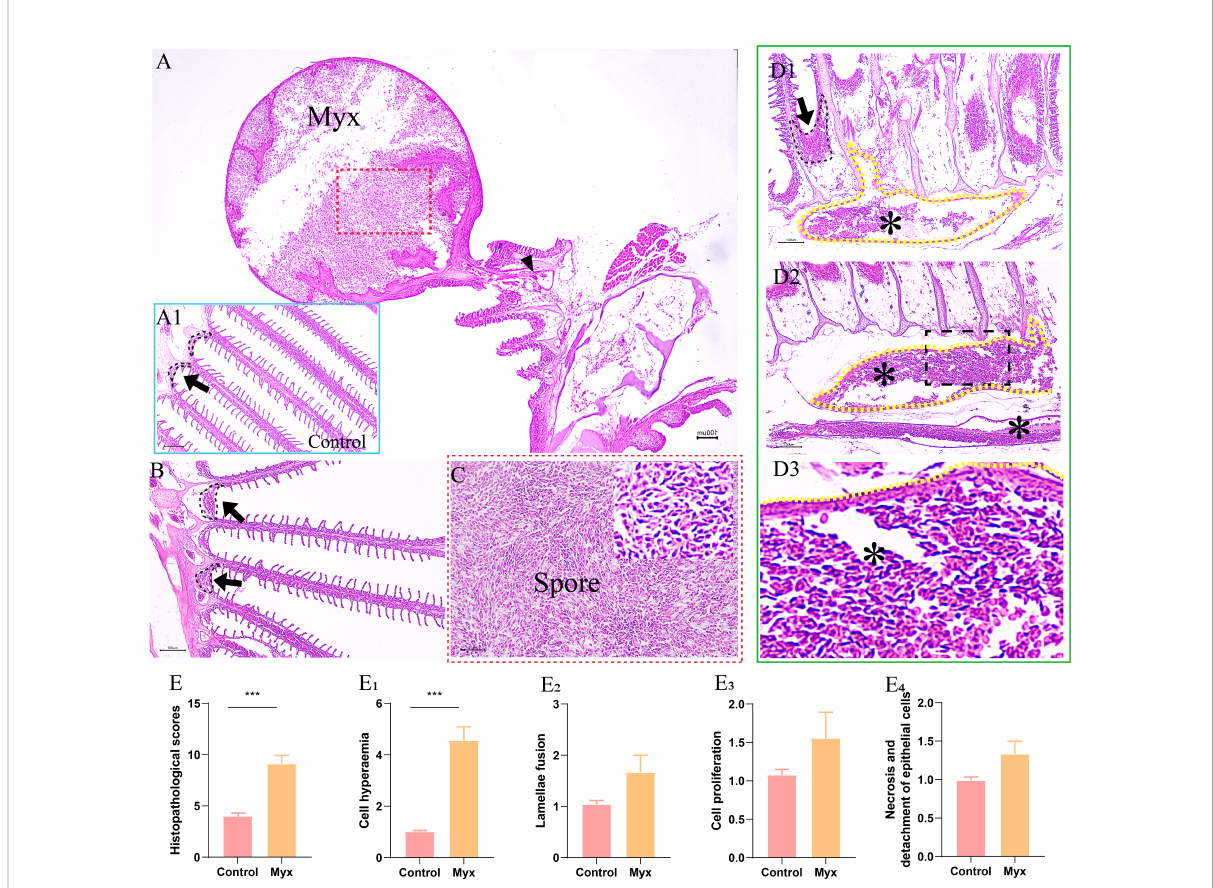
FIGURE 4 Histopathological observation of gills of gold fi sh infected with Myxobolus ampullicapsulatus . (A) Round cysts attaching to gill fi laments contained a large number of spores (red dotted box), some of which released from the cysts and entered the gill tissue through the branchial artery (black triangle). (A1) Control group gold fi sh, with neatly arranged gill lamellae, showing continuous gill-associated lymphoid tissue (black dotted line and black arrow) formed on the gill arch. (B) The gill-associated lymphoid tissue in Myx group was dilated (black dotted line and black arrow). (C) Partial enlargement (red dotted box) of Figure A, dense spores can be seen. (D) The gill of Myx gold fi sh showed obvious hyperemia (*) (P value), accompanied by a large number of spores distributed in the afferent branchial artery (yellow dotted line) (E) Total score of gill histopathological score; (E 1 – E 4 ) The histopathological scores for cell hyperaemia, lamellae fusion, cell hyperplasia, and necrotic and detachment of epithelial cells, respectively. Signi fi cance: P < 0.05 (*), P < 0.01 (**), P < 0.001 (***). (n=6).